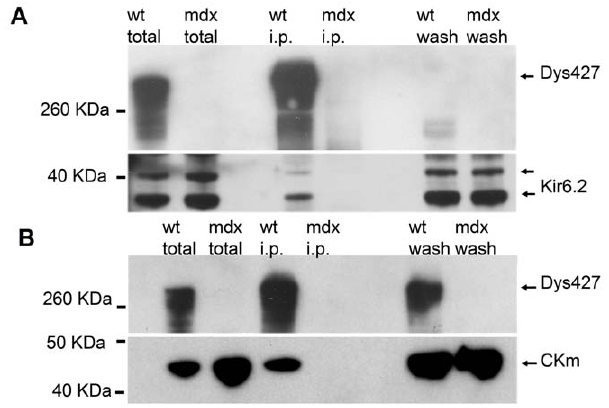
Figure 6. Kir6.2 and CKm co-immunoprecipitate with Dys427. A) Cardiac lysates from wt and mdx animals were immunoprecipitated with an anti Dys427 antibody and probed for the presence of Kir6.2 (lower part). The membrane was then re-probed with the anti Dys427 antibody (upper part). Kir6.2 is abundant in the total lysate of both wt and mdx hearts but co-immunoprecipitates with Dys427 only in the wt sample. B) CKm interacts with dystrophin. Samples as in A were probed with an anti CKm antibody (lower panel) The membrane was subsequently reprobed with an anti Dys427 antibody (upper part). Note that CKm is abundant in the total lysate of both wt and mdx hearts but co-immuno precipitate with Dys427 only in the wt sample.